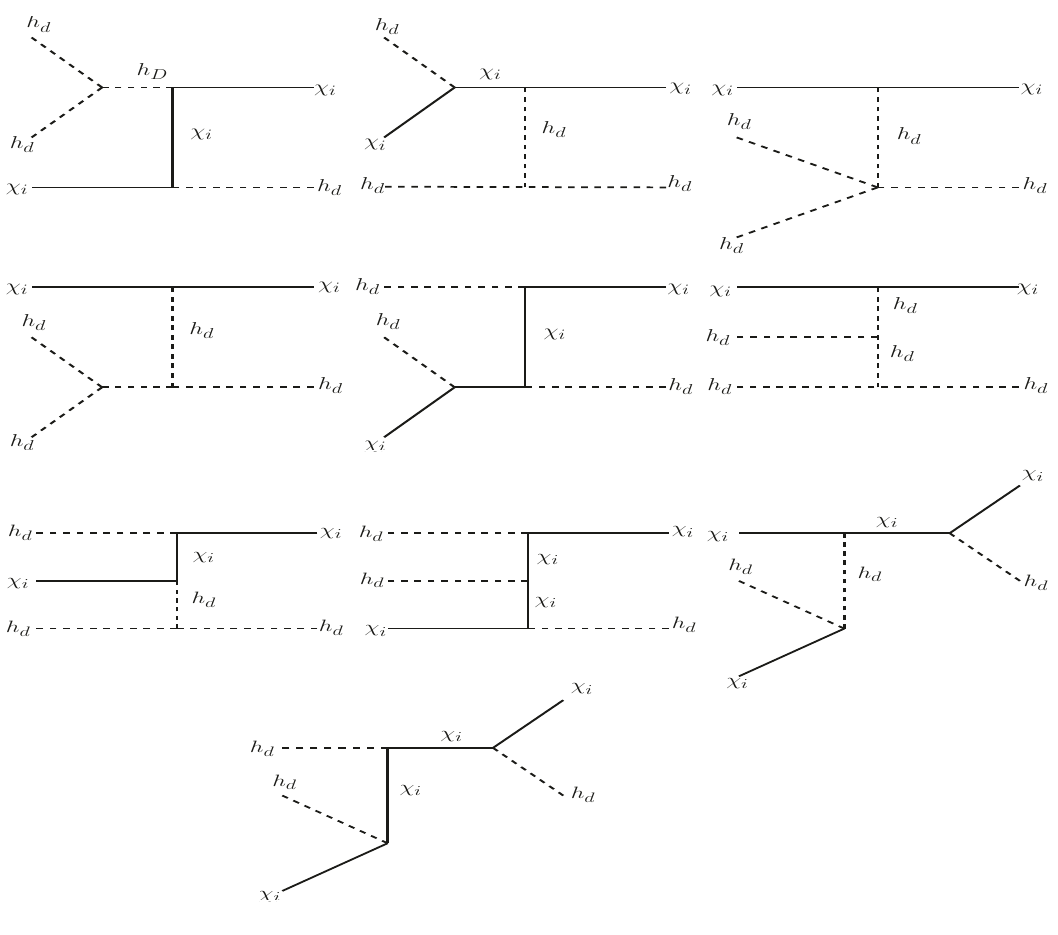
Figure 19 . Feynman diagrams for χ